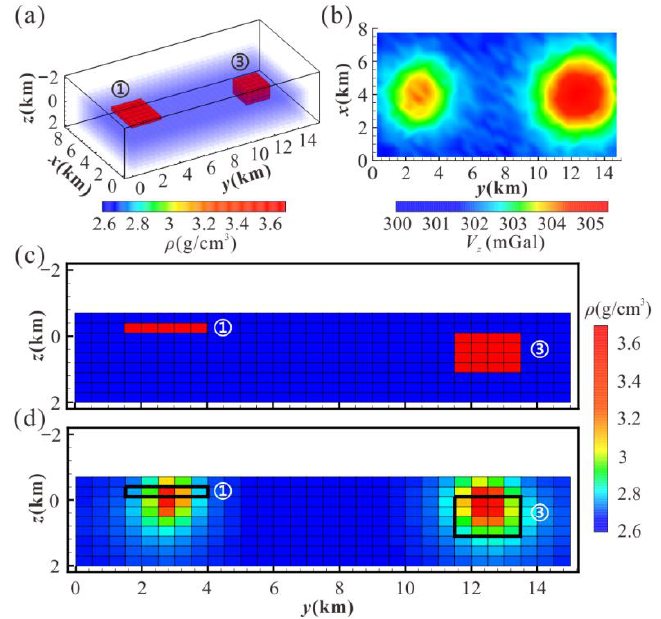
Figure 8. ( a ) Real density model; ( b ) observation data; ( c , d ) density slice of the real model and inversion result at x = 4000 m.